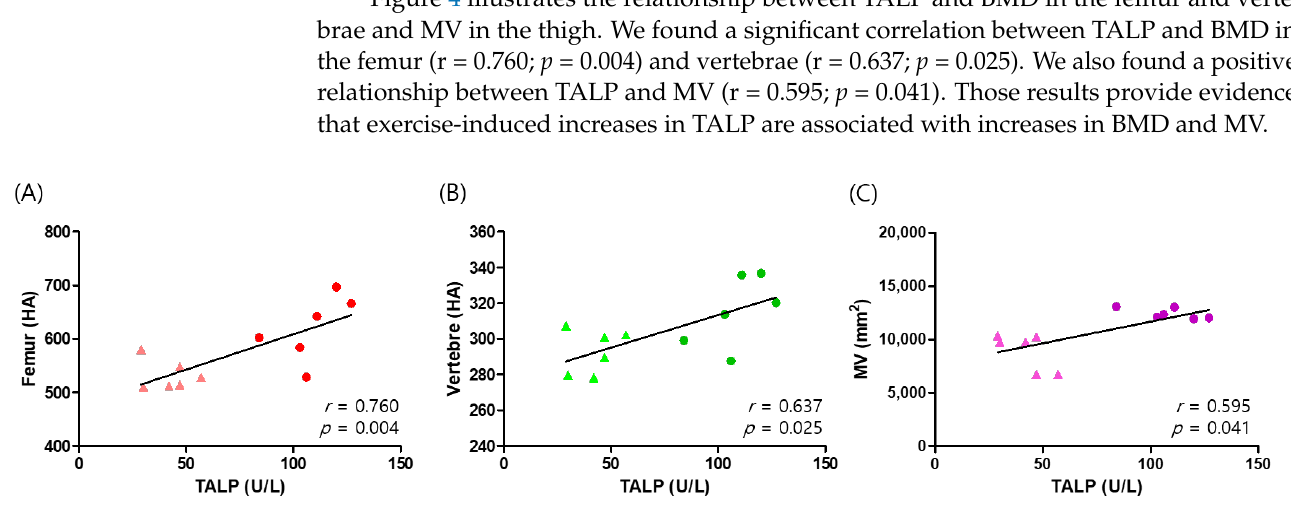
Figure 4. Correlations between total alkaline phosphatase (TALP) and bone mineral density (BMD) and muscle volume (MV) in dogs. ( A ) Correlation between TALP and individual BMD at the femur. ( B ) Correlation between TALP and individual BMD at the vertebrae. ( C ) Correlation between TALP and individual MV. The triangles show pre-exercise TALP samples, and the circles show post-exercise.